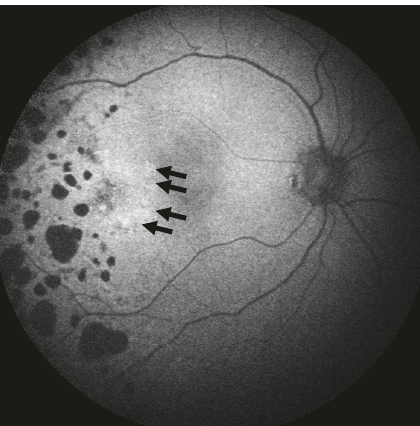
Figure 1: Fundus autofluorescence (FAF) right eye at baseline. Note the laser scars appears as heterogeneous hypoAF foci in the temporal fundus of the right eye. Nasal to these, in the temporal macula, note the curvilinear group of faint hyperAF foci (black arrows).